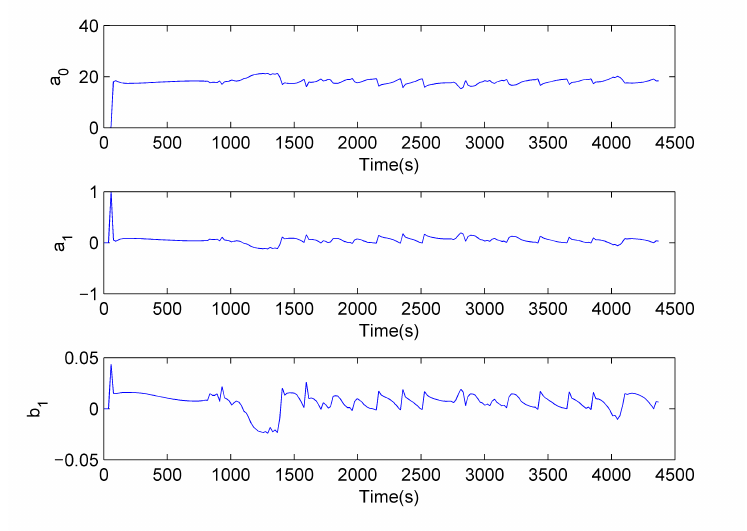
Figure 11. Parameter estimation of the proposed method for time-varying